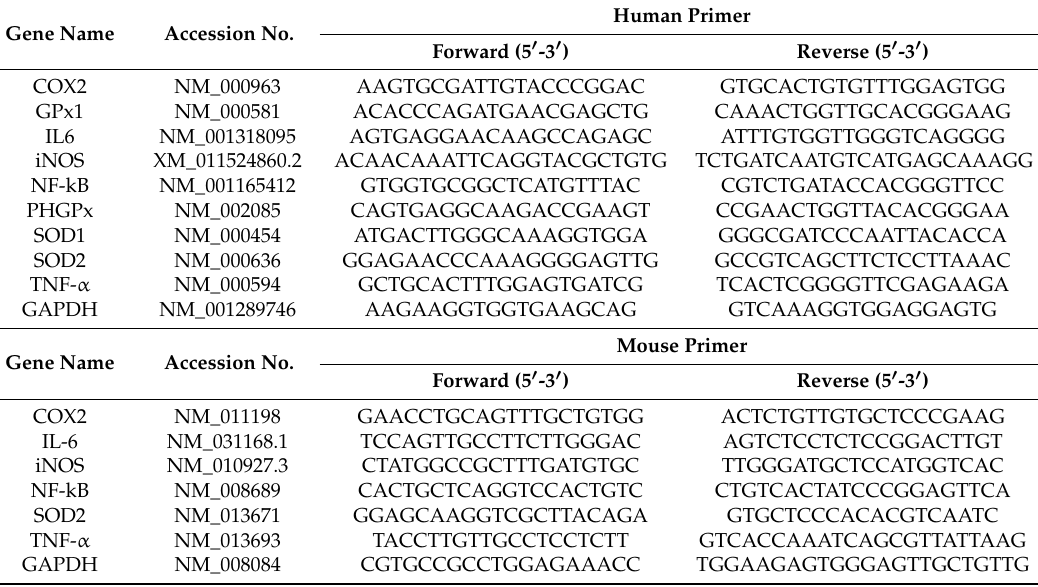
Table 2. Sequences of the primers used in the current